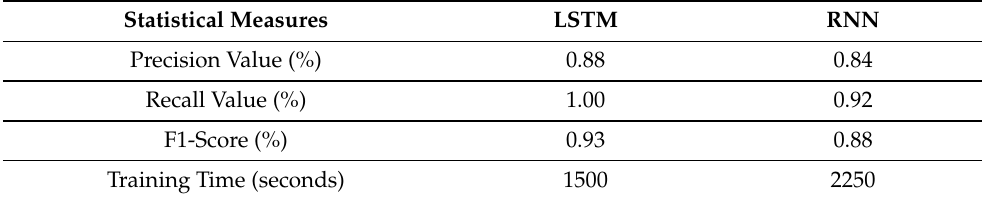
Table 5. Comparison of LSTM and